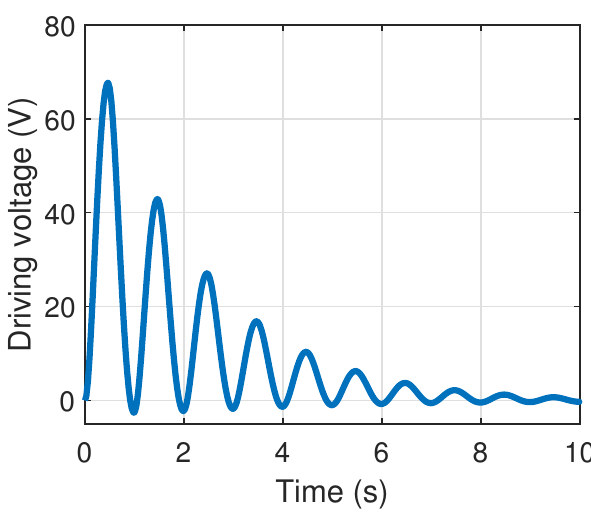
Figure 17. Control voltage considering time-dependent magnitude strain